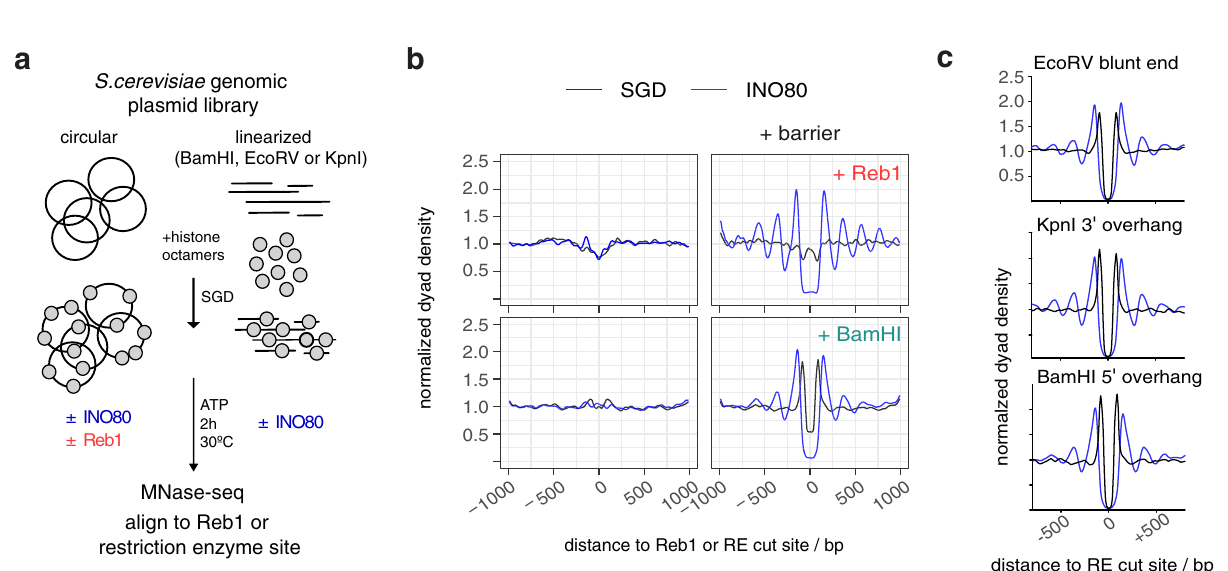
Fig. 7 INO80 synergistically integrates nucleosome positioning information from DNA shape/mechanics and Reb1 barriers. a Composite plots as in Fig. 6b, but merge of four replicates (Supplementary Data 1) of SGD chromatin with recombinant human histones at histone-to-DNA mass ratio 0.4 incubated with recombinant S. cerevisiae WT INO80 plotted for either 456 genes with promoter Reb1 PWM sites or for a randomly selected but same number of genes with no GRF-PWM sites (Reb1, Abf1, Rap1, Mcm1, Cbf1 88 ) in their promoters. b As in a but for matched replicate (replicate 8, Supplementary Data 1) comparing SGD chromatin with embryonic fl y ( D. m .) or recombinant human ( H. s .) histones, ± 20 nM Reb1 and for 620 genes with promoter anti-Reb1-SLIM-ChIP sites (as in Fig. 6a, red shading, and in Fig. 6b, top). c Distributions of distances between + 1 nucleosome positions at 620 Reb1 site-containing promoters in vivo and reconstituted by incubation of SGD chromatin with the indicated histone-to-DNA mass ratios with recombinant S. cerevisiae WT INO80 in the presence (Reb1) or absence (none) of 20 nM Reb1. Dots show independent replicates ( n = 4 or 12 or 7 for histone-to-DNA ratio of 0.2 or 0.4 or 0.8, respectively, and for ±Reb1 each; either recombinant human or endogenous fl y embryo histones were used, see Supplementary Data 1 and GEO deposition at GSE140614. For histone-to-DNA ratio 0.2 and 0.8 data and for detailed description and more examples of such distances between nucleosomes and barriers and their dependencies on nucleosome density and remodelers see accompanying paper 39 . Larger horizontal bars represent mean, error bars standard deviation. d As in b but only SGD chromatin with recombinant human histones incubated with recombinant S. cerevisiae WT INO80 ± 20 nM Reb1.MNase-seq data were merged (four replicates without and seven replicates with Reb1 (Supplementary Data 1)) and aligned at Reb1 PWM sites of groups, which were de fi ned according to promoter uni- versus bidirectionality and Reb1 PWM orientation as indicated. Only Reb1 sites in promoters and only if identi fi ed by both anti-Reb1-SLIM-ChIP and Reb1 PWM were used (see also accompanying paper 39 ). e Reb1 PWM- aligned composite plots for gene groups as in d . From top to bottom: anti-Reb1-SLIM-ChIP signal (Reb1 signal) and zoom in on distribution of DNA rigidity, propeller twist and helix twist DNA shape features, and positions of poly(dA) or poly(dT) elements (hexa-homopolymeric stretches) around Reb1 sites, each with Reb1 signal. Gray background in all panels shows composite plot of MNase-seq data with Reb1 as in d .